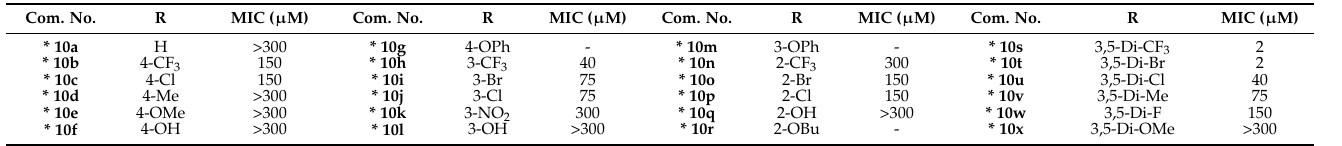
Table 18. Antibacterial activity of carboxylated chalcones against S. aureus .